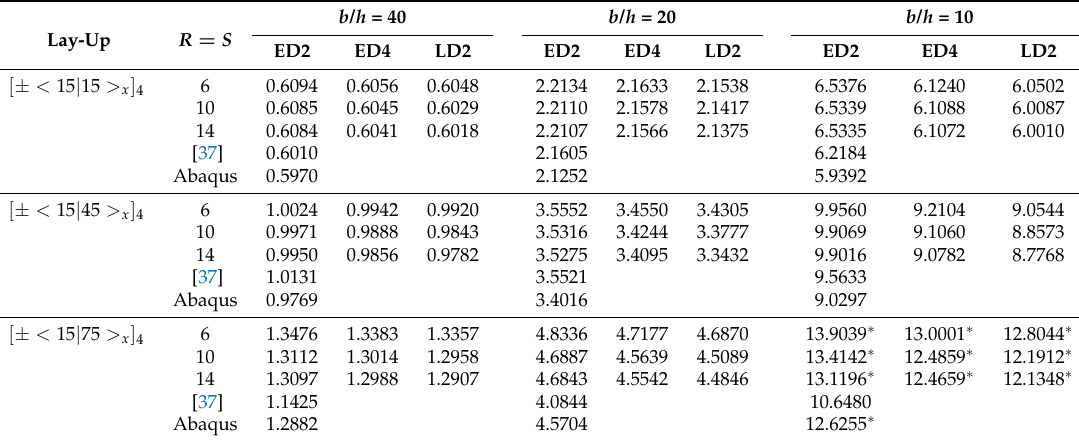
Table 2. Non-dimensional buckling temperatures T cr α 11 × 10 3 for SSSS variable-stiffness plates: convergence over the number of trial functions and for various kinematic theories. ( ∗ denotes the presence of smaller eigenvalues associated with local modes) b / h = 40 b / h = 20 R = S ED2 ED4 LD2